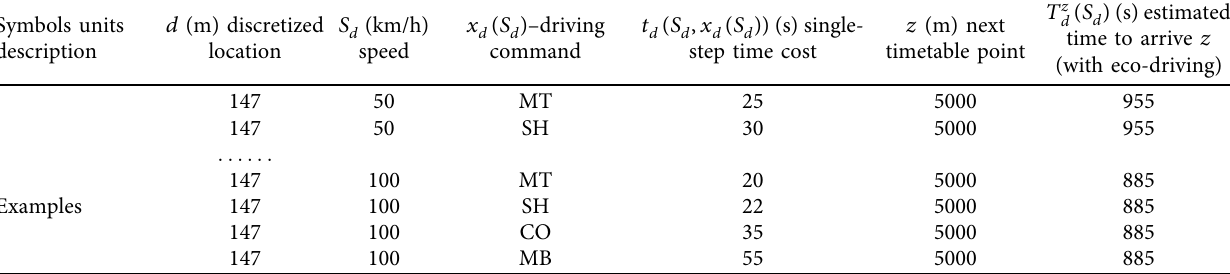
Table 2: Speed profile lookup table